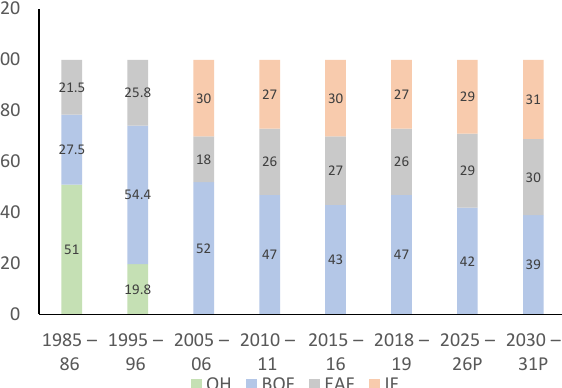
Figure 8. Process-wise crude steel production since 1985 and a forecast to 2030 (graph plotted using data from Ministry of Steel).